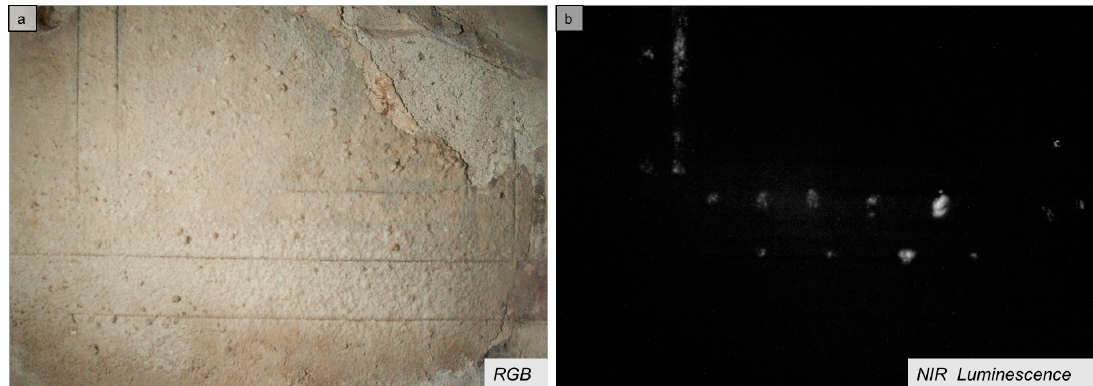
Figure 26. ( a ) A color (RGB) image of the painted slab sealing the loculus in Tomb Roma 2 (K). The heavy salt encrustation covers much of the surface and leaves only incision lines noticeable. ( b ) The NIR luminescence of Egyptian blue capture reveals patterns of dots and lines under the